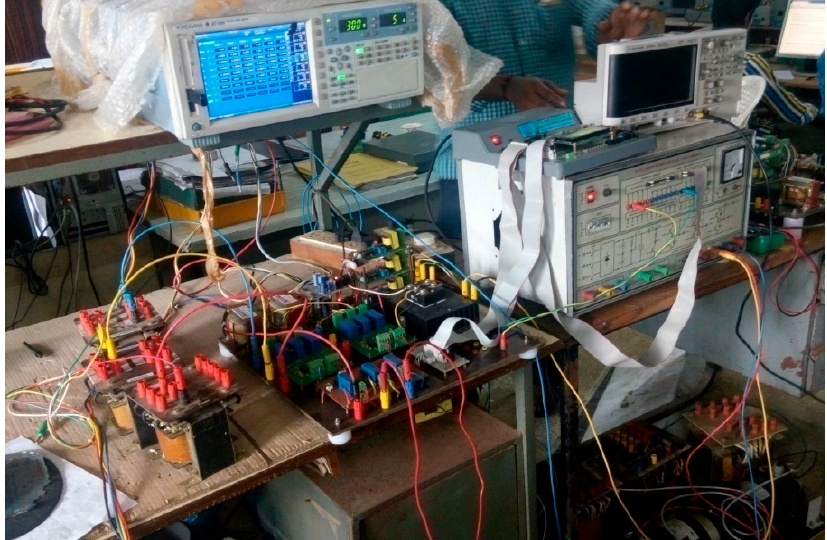
Figure 11. Experimental setup.